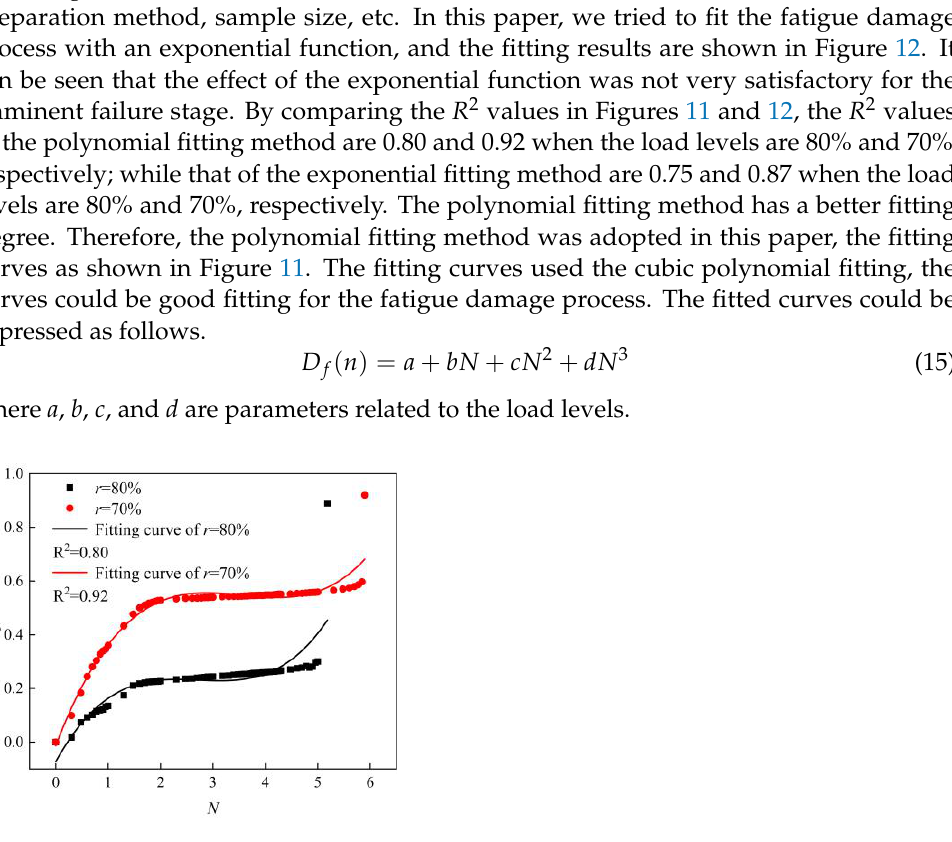
Figure 11. Fatigue damage curves. (Specimens made by the powder metallurgy method, N = lg n ).